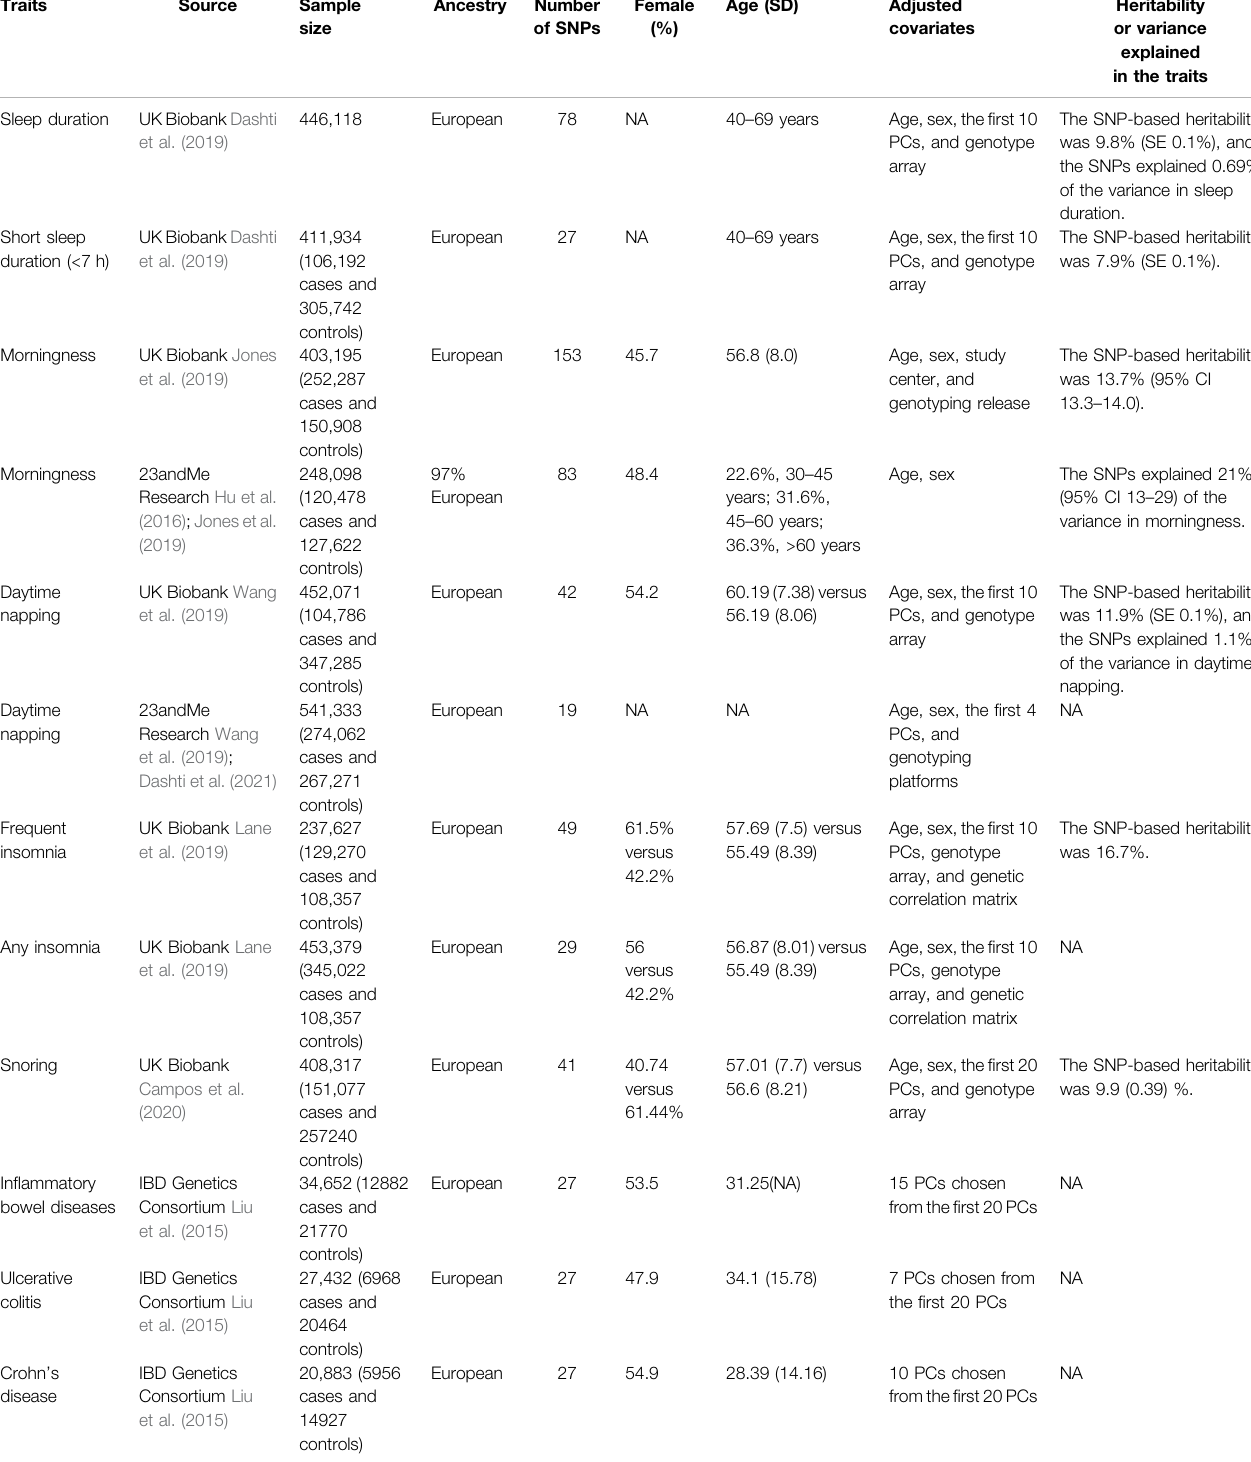
TABLE 1 | Characteristics of the study